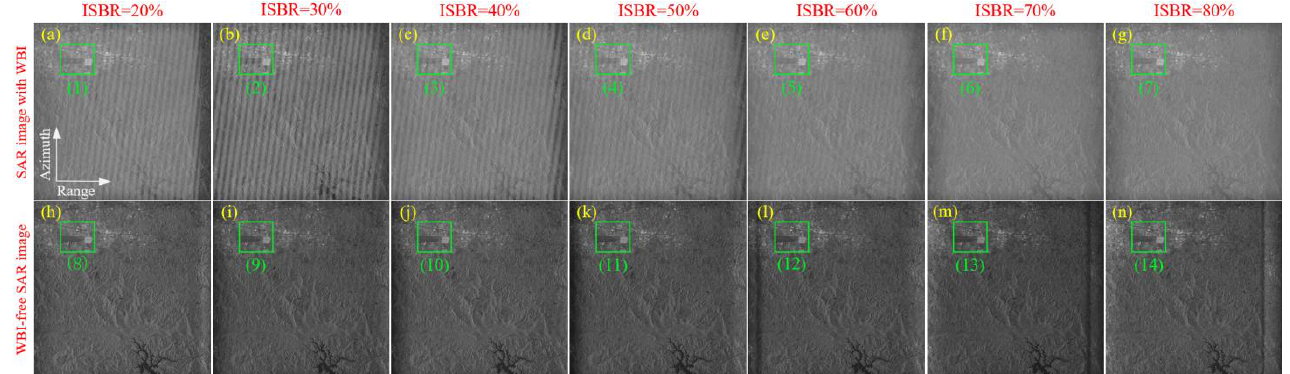
Figure 7. Simulated interference mitigation results in different ISBRs. ( a – g ) Contaminated SAR images with ISBR of 20%, 30%, 40%, 50%, 60%, 70%, 80%, respectively. ( h – n ) Mitigated SAR images with ISBR of 20%, 30%, 40%, 50%, 60%, 70%, and 80%, respectively. (1) – (14) ROIs in ( a – n ) with green boxes.